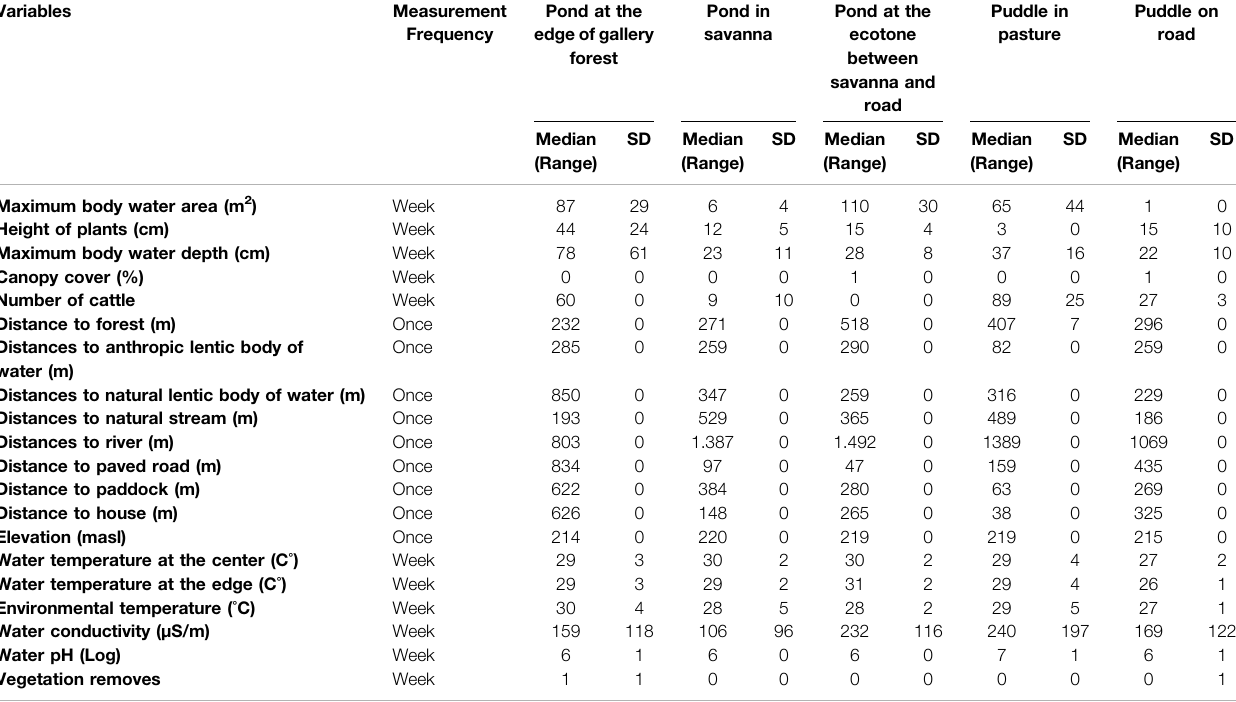
TABLE 1 | Structural and environmental characterization of fi ve bodies of water in tropical fl ooded savanna at the Yopal Municipality (Casanare Department, Colombia). Variables Measurement